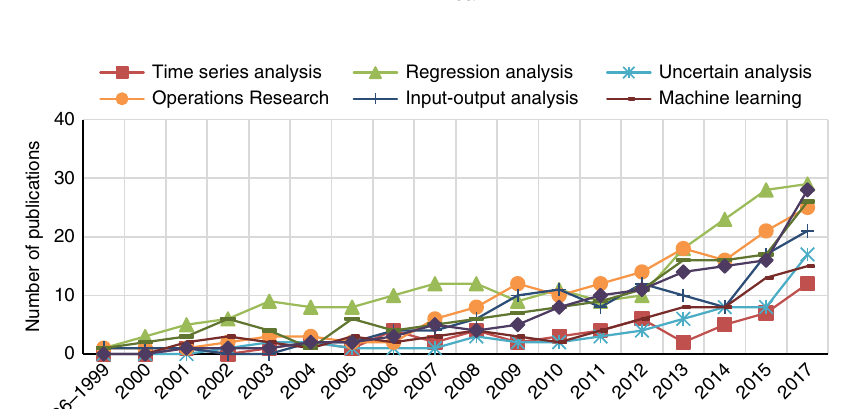
Figure 1. Number of published documents in the field of marine